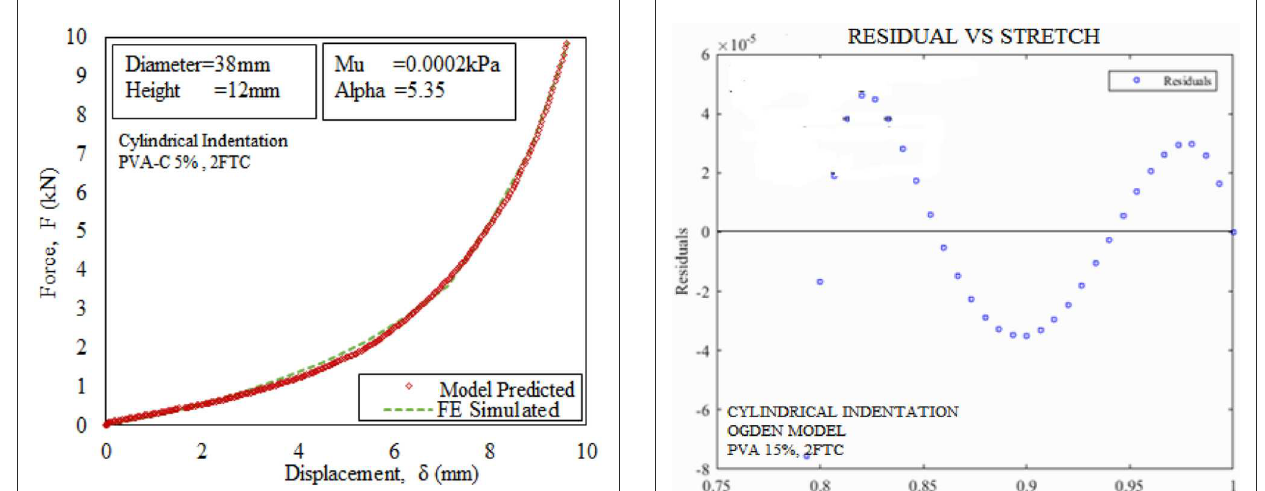
FIGURE10 Residual vs. stretch graph for PVA-C samples with 15% concentration, where fitness coefficient is R 2 =